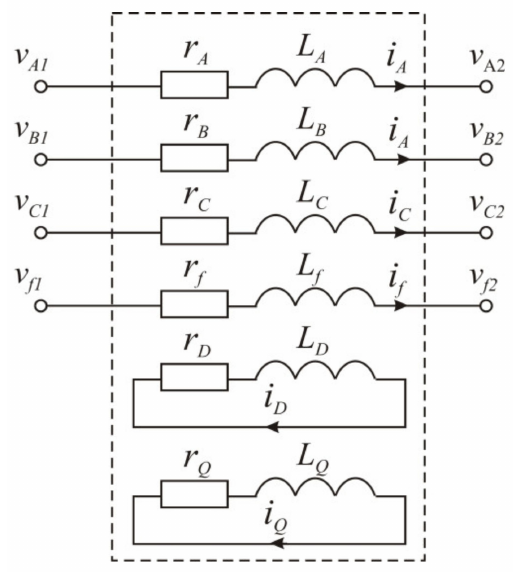
Figure 1. Calculation scheme of the synchronous